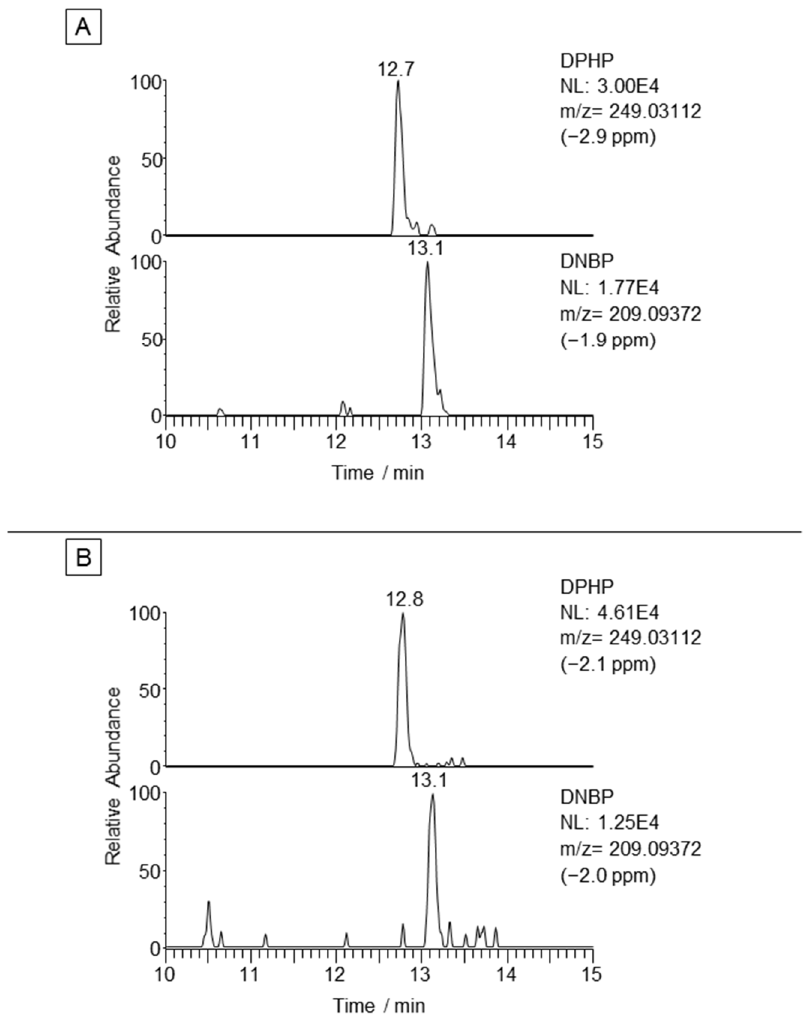
Figure 4. LC-HRMS extracted ion chromatogram of a hake ( A ) and a tuna ( B ) sample. DPHP and DNBP were determined in all the samples and their presence was con- firmed with a mass error below 5 ppm and the expected ion ratios. The concentrations of